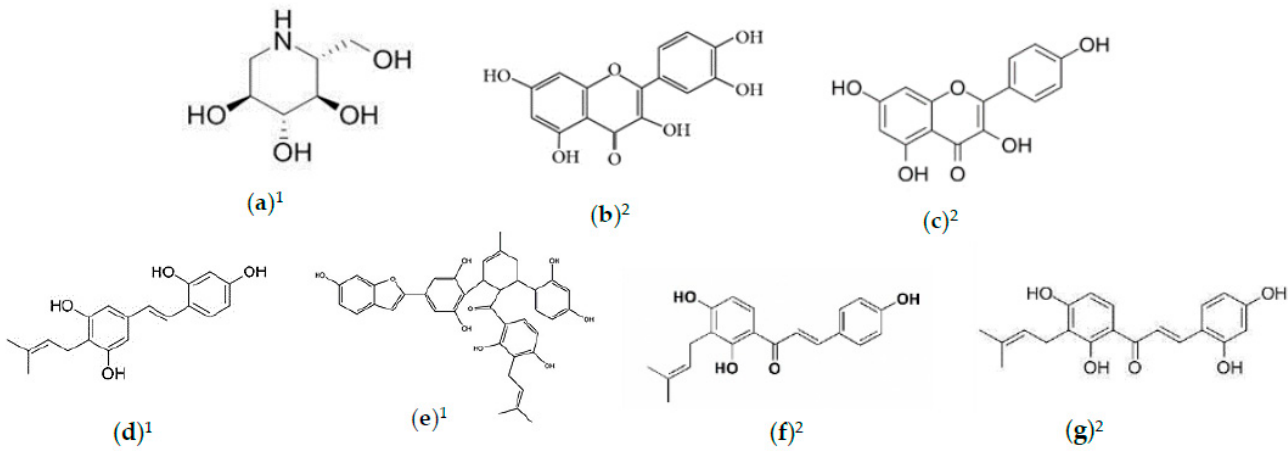
Figure 2. Natural compounds with antidiabetic activities. ( a ) 1-Deoxynojirimycin (DNJ); ( b ) quercetin; ( c ) kaempferol; ( d ) 4 ′ -prenyloxyresveratrol; ( e ) chalcomoracin; ( f ) isobavachalcone; ( g ) morachalcone. 1 Refers to compounds in M. alba leaves; 2 refers to compounds in M. alba fruit.